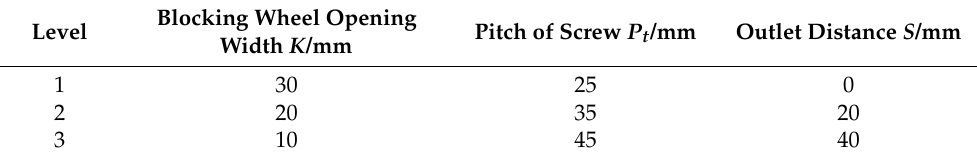
Table 3. Factors and levels of influence of the orthogonal test.